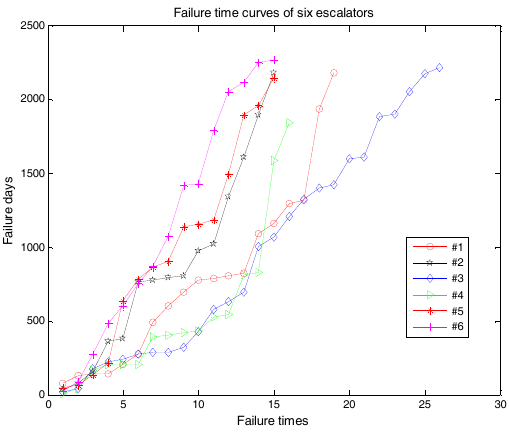
Figure 9. Failure time curve of six escalators.